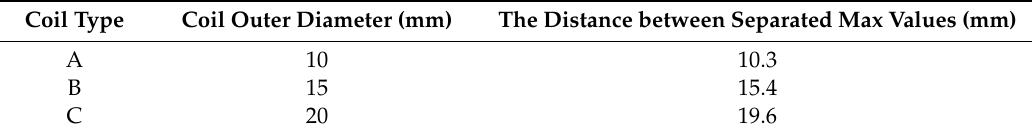
Table 4. The distance between separated maximum values for di ff erent sensors.